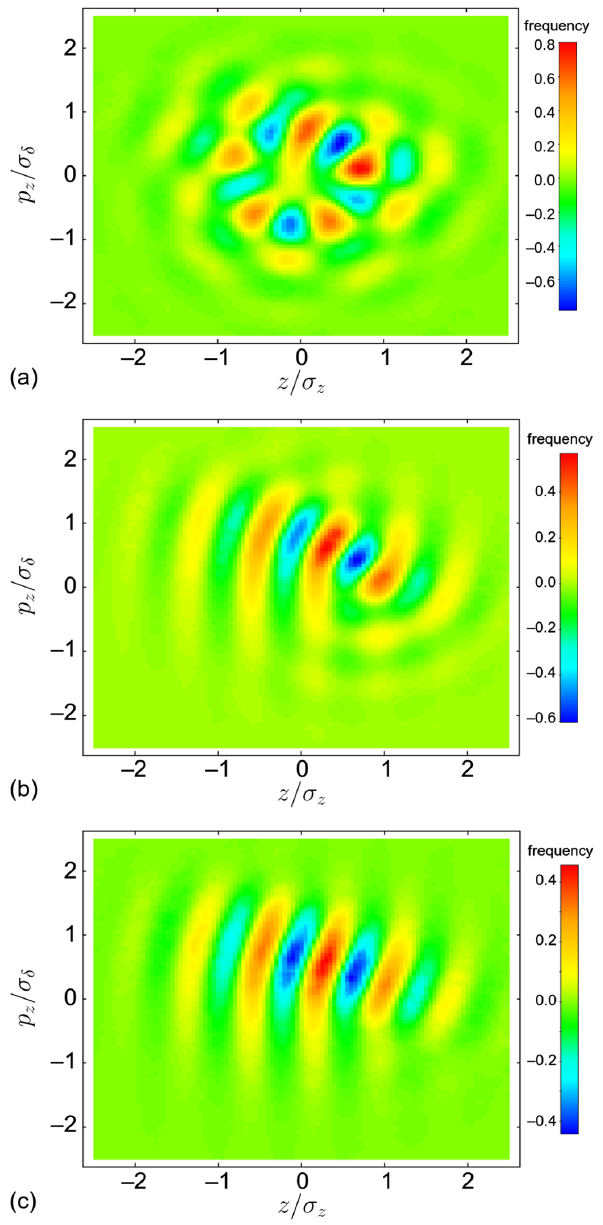
FIG. 5. Unstable longitudinal phase space density perturbations 8 . Panel (a) has extracted from ELEGANT simulations for k ξ σ z ¼ no synchrotron emission and displays a complicated azimuthal ˆ λ dependence with m ≈ 5 symmetry when ℑ ð Þ ¼ 5 and chroma- ticity plays an important role to control the instability. This contrasts with panel (b) for which the perturbation becomes more aligned with the p axis as the wakefield strength increases such z ˆ λ that ℑ ð Þ ¼ 7 > 3 k ξ σ z = 4 . Panel (c) has the same parameters as (b) but also includes synchrotron